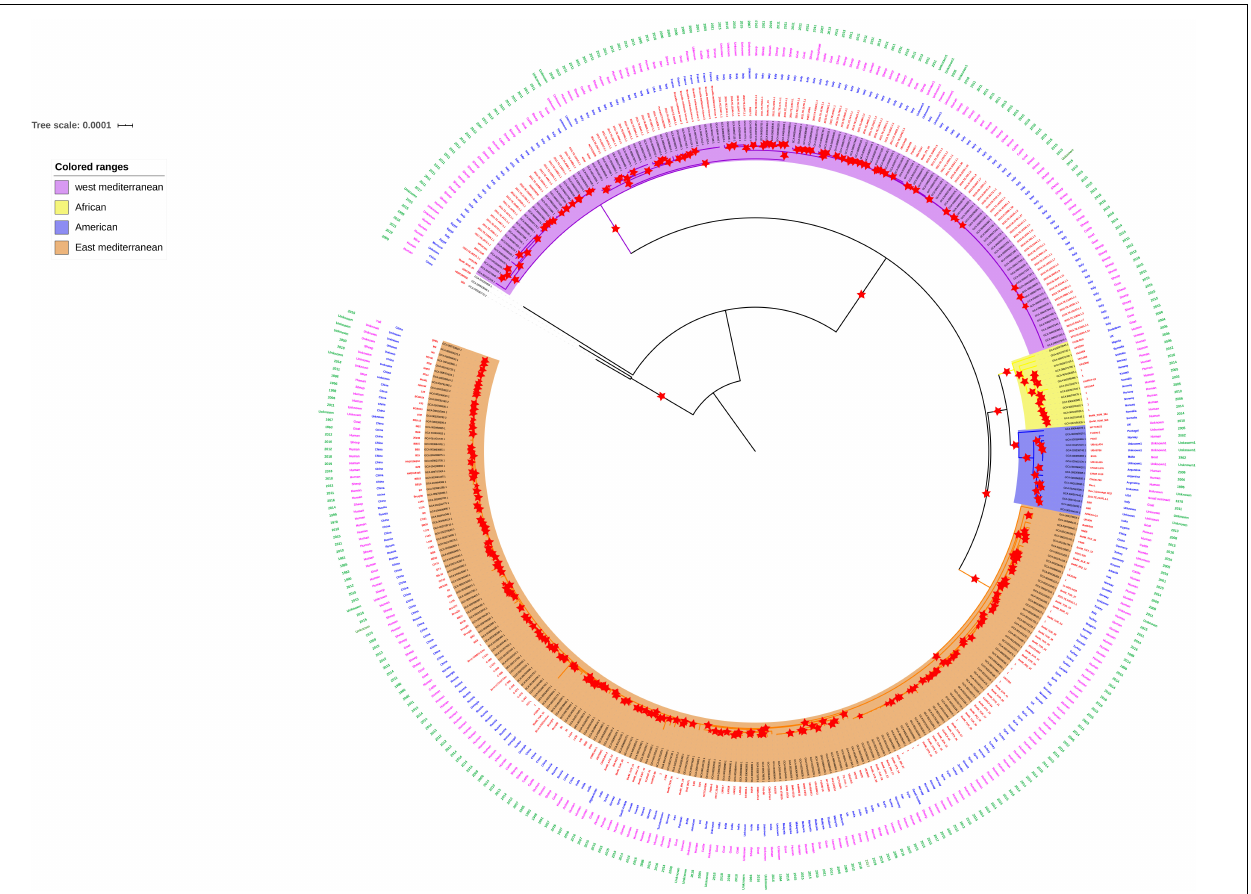
FIGURE 1 | Whole genome phylogeny. Four clusters, namely, West Mediterranean, East Mediterranean, African, and American were grouped in the phylogeny. Most of the Indian strains including TN_CUL_1 fall in the East Mediterranean cluster. Red star symbol indicates boot strap values of more than 80.